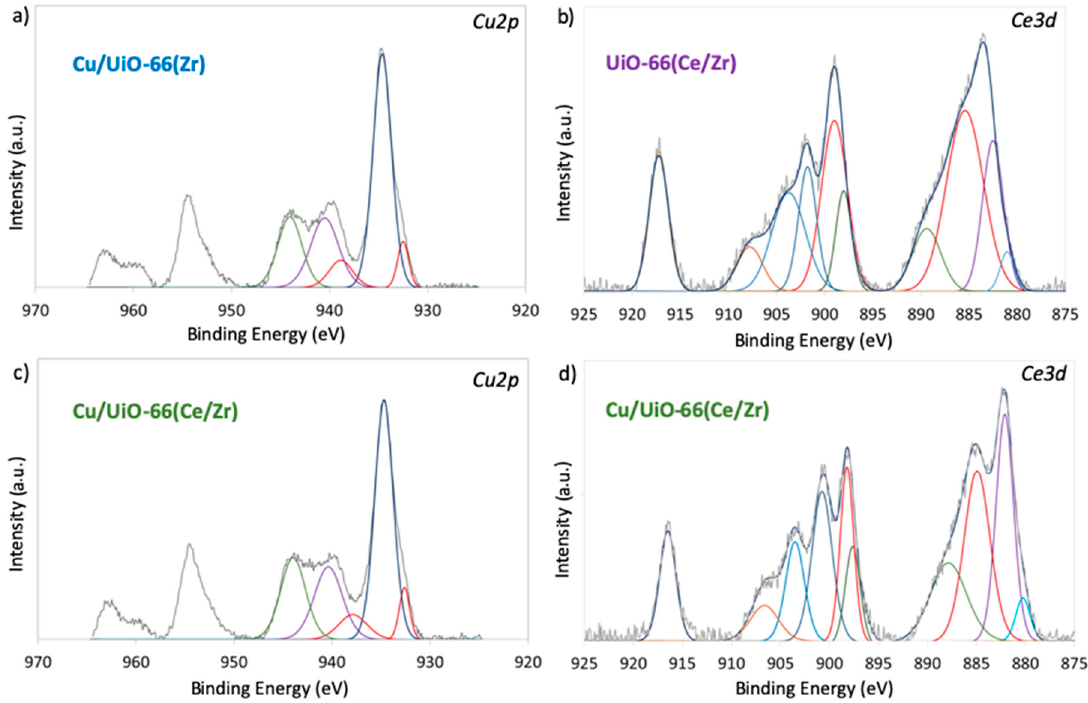
Figure 3 . Cu2p and Ce3d X-ray photoelectron spectroscopy (XPS) spectra for Cu/UiO-66(Zr) ( a ), UiO-66(Ce/Zr) ( b ), and Cu/UiO-66(Ce/Zr) ( c , d ).